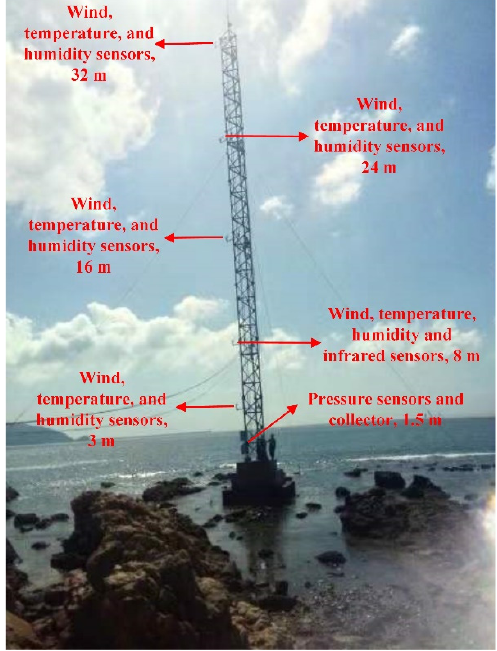
Figure 5. Measurement system of evaporation duct based on an iron tower platform.